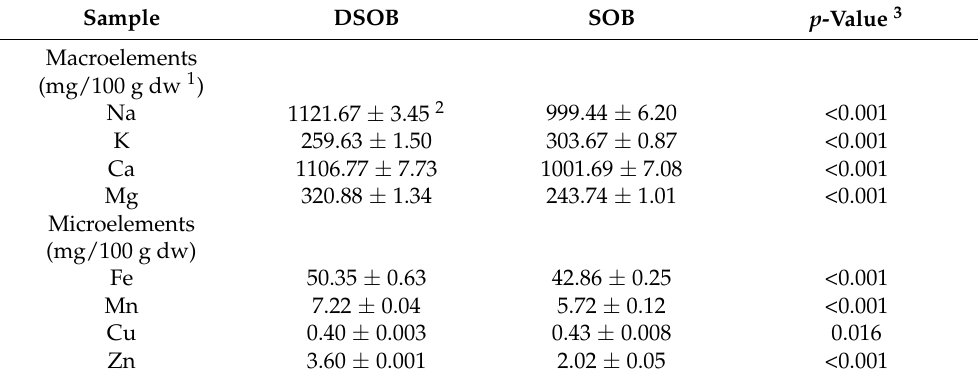
Table 8. The contents of minerals in defatted seeds of Oenothera biennis (DSOB) and seeds of Oenothera biennis